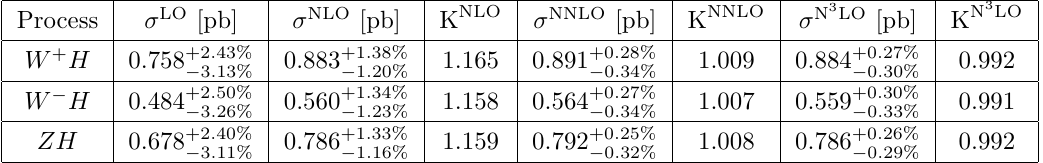
Table 2 . Same as in table 1, but for a dynamical central scale choice µ 0 = M V H